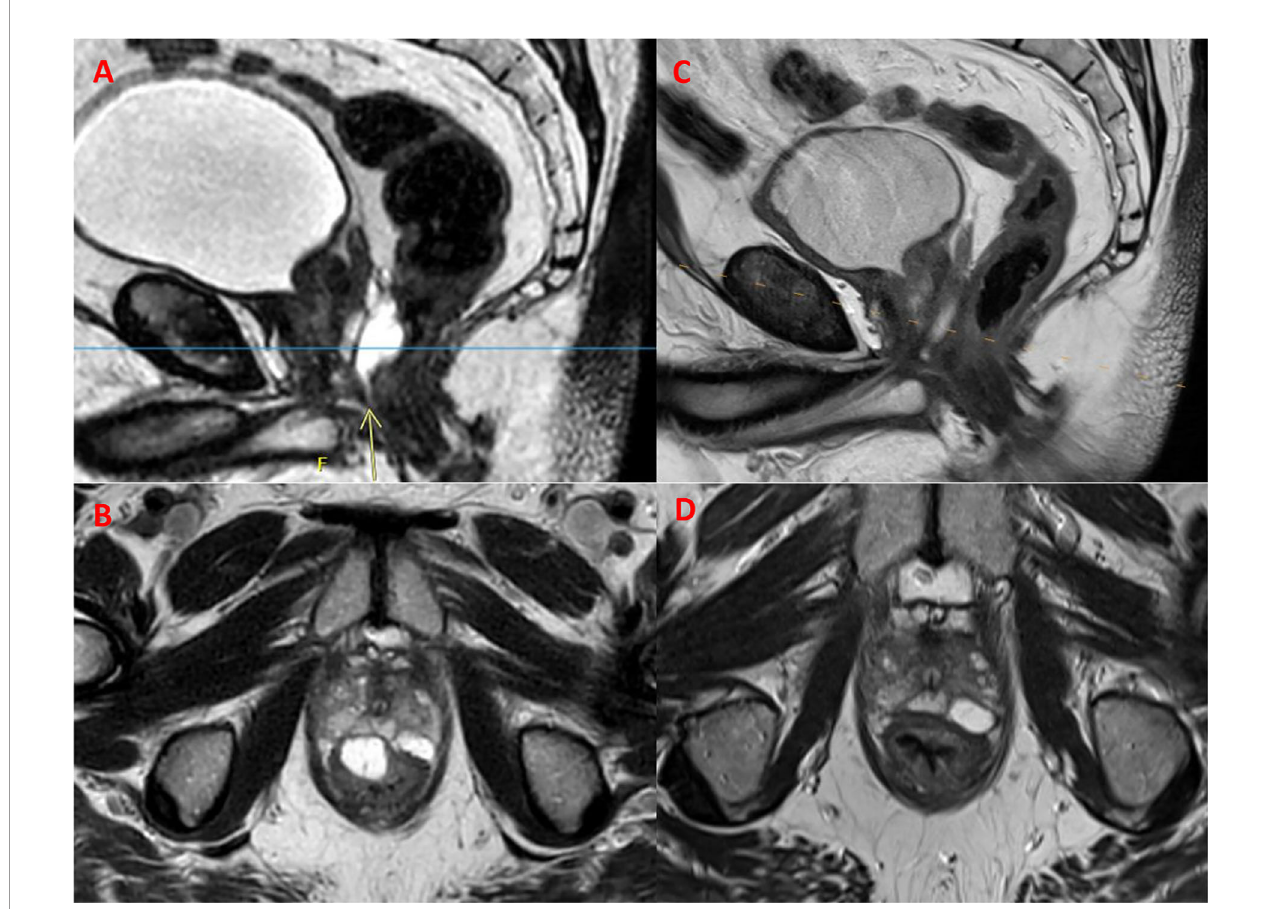
FIGURE 1 | Magnetic resonance images demonstrating intramural non-animal stabilized hyaluronic acid (NASHA) in (A) sagittal and (B) axial views denoted by*. Two days post hyaluronidase injection, the intramural NASHA is no longer visible in the same views (C, D)